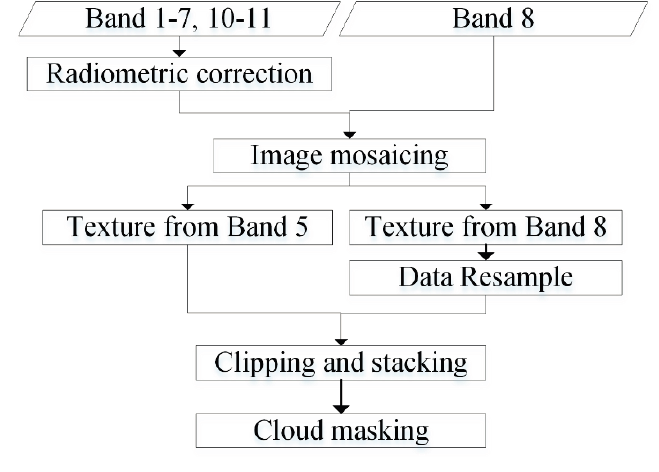
Figure 2. Block diagram of data